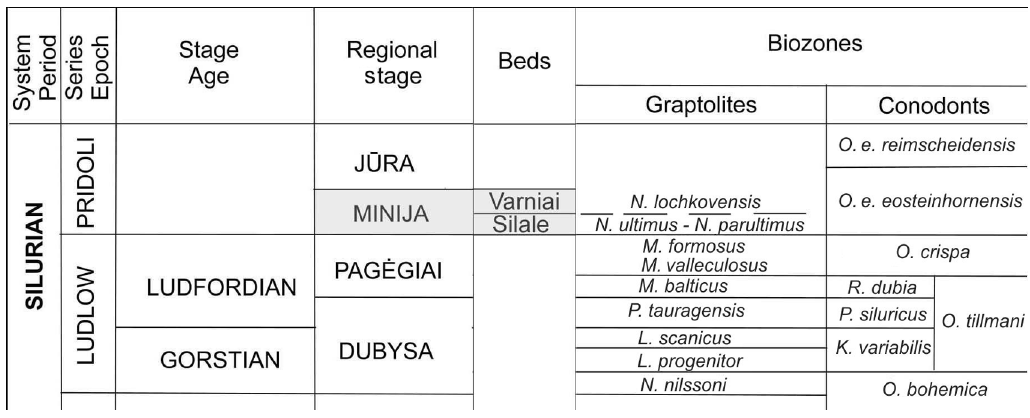
Fig. 1. The Upper Silurian stratigraphy of Lithuania, modified according to Pa(cid:154)kevi č ius (1997).